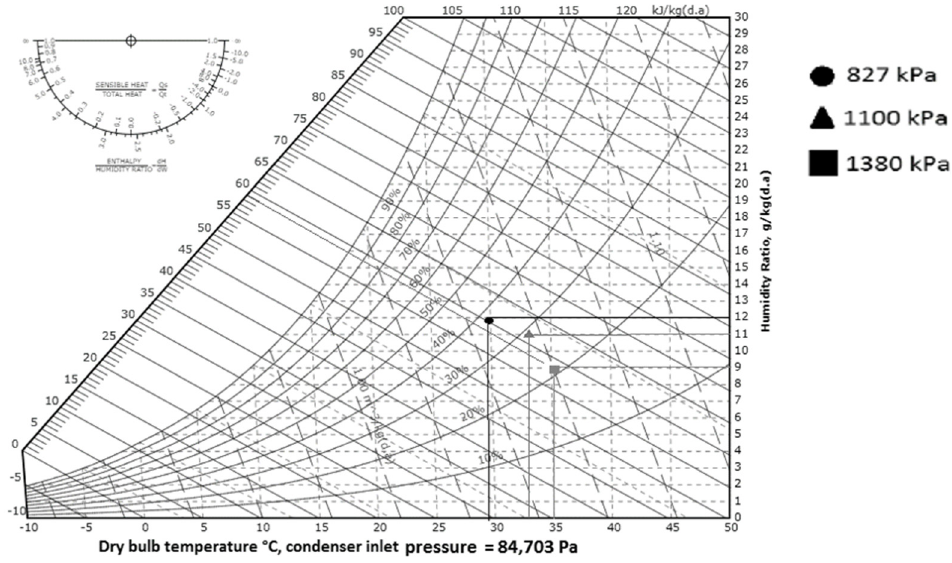
Figure 4. Air humidity ratio at the entrance of the drying chamber for each pressures evaluated.